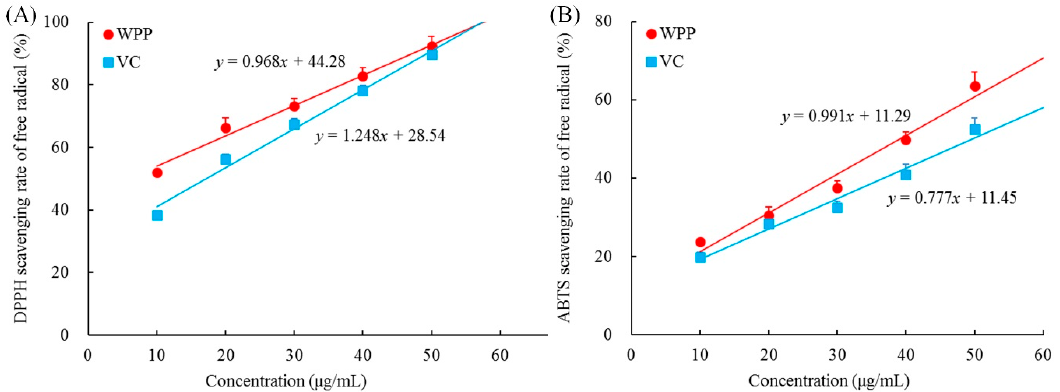
Figure 1. Free radicals scavenging rate of 2,2-Diphenyl-1-picrylhydrazyl (DPPH) ( A ) and 2,2’-azino-bis(3-ethylbenzothiazoline-6-sulfonic acid (ABTS) ( B ). WPP: white peony polyphenols; VC: vitamin C (ascorbic acid).